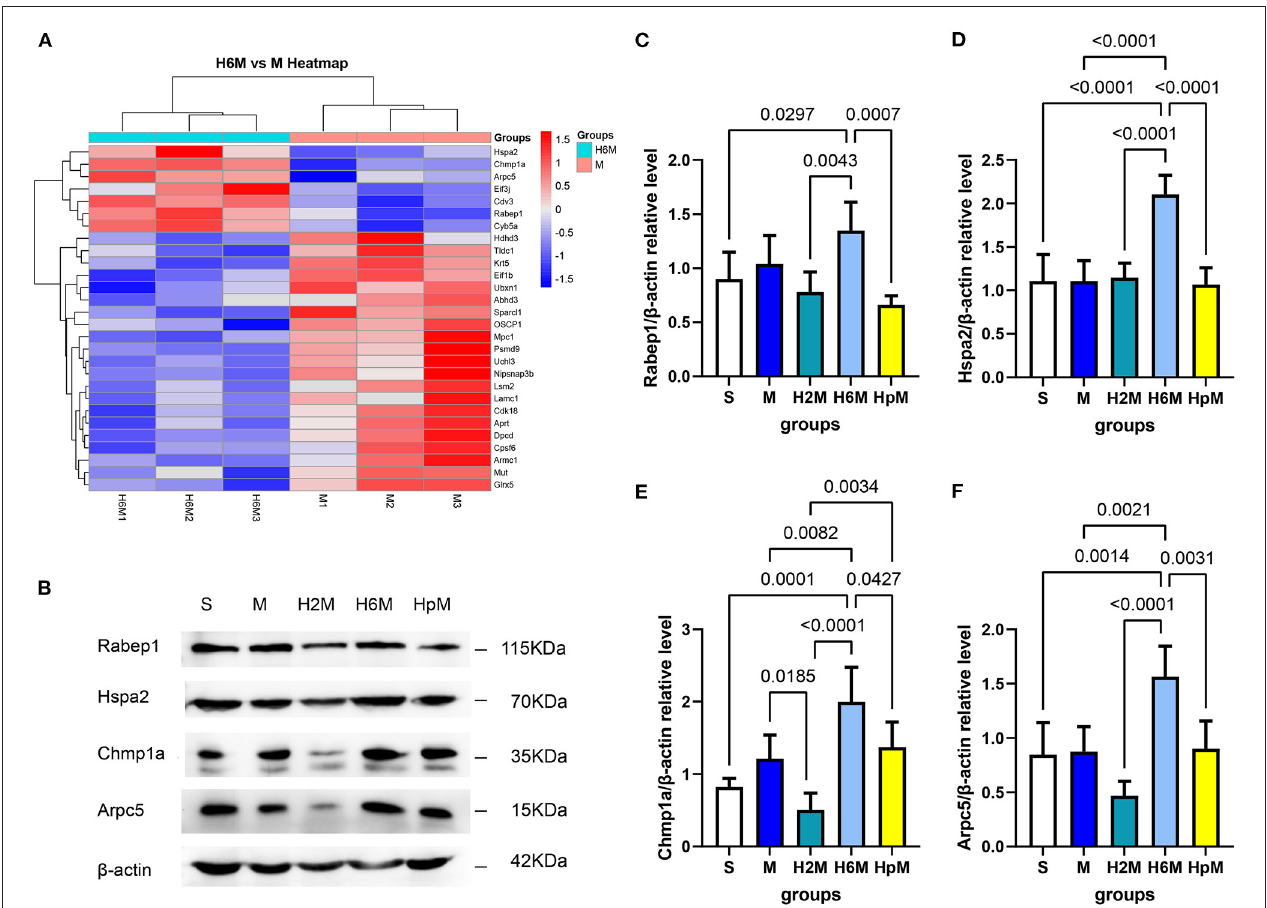
FIGURE 6 | Cluster analysis of significantly different protein expressions and western blot analysis of selected key proteins. (A) Cluster analysis (H6M vs. M). Red represents up-regulation and blue represents down-regulation. (B) Western blotting results of four differentially expressed endocytosis-related proteins. (C) A western blotting gray value analysis of Rabep1. One-way ANOVA showed differences among the five groups, F = 7.34, p = 0.0008. Results are presented as mean ± SD ( n = 5). (D) A western blotting gray value analysis of Hspa2. One-way ANOVA showed differences among the five groups, F = 19.29, p < 0.0001. Results are presented as mean ± SD ( n = 5). (E) A western blotting gray value analysis of Chmp1a. One-way ANOVA showed differences among the five groups, F = 15.43, p < 0.0001. Results are presented as mean ± SD ( n = 5). (F) A western blotting gray value analysis of Arpc5. One-way ANOVA showed differences among the five groups, F = 13.04, p < 0.0001. Results are presented as mean ± SD ( n = 5). ANOVA, analysis of